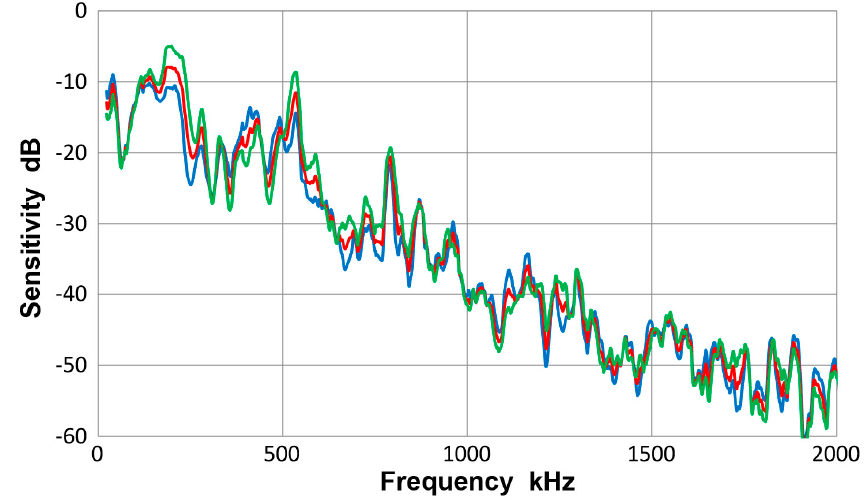
Figure A6. Receiving sensitivity of PAC HD50 sensor. Red -averaged guided wave sensitivity, blue -Lamb waves for 12.7 and 6.4 mm plates, green -bar waves for 12.7 and 6.4 mm